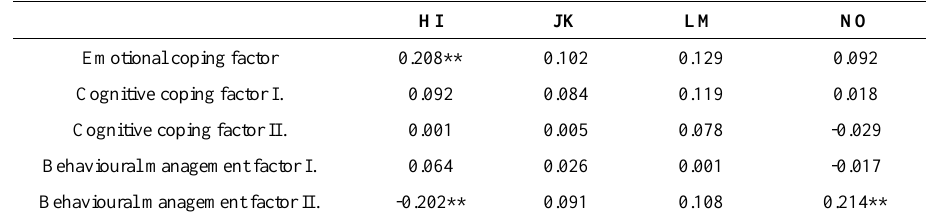
Table 2. Correlations between behaviours in demanding situations of project manager work and characteristics of the interpersonal behaviour of managers-continuation. HI JK